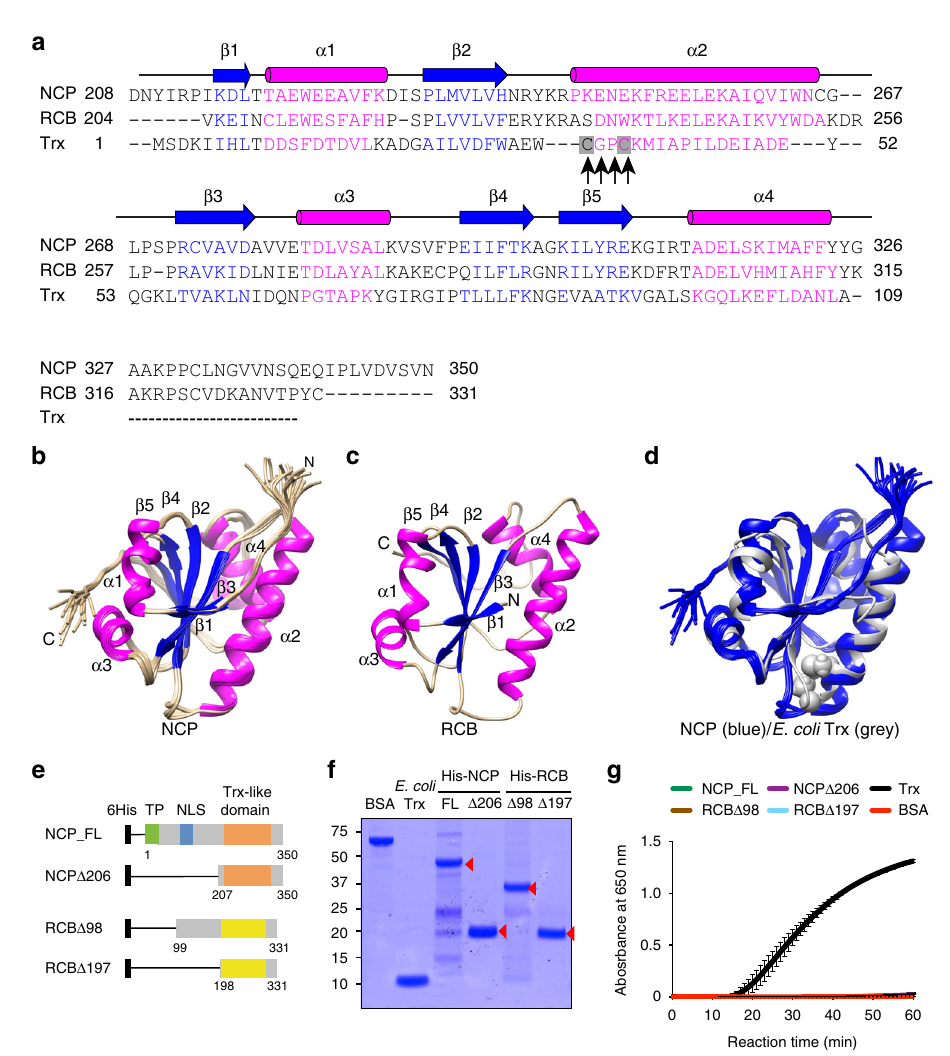
Fig. 6 NCP and RCB structurally resemble E. coli Trx but lack reductase activity. a Sequence alignment of the Trx-like domains of NCP and RCB with that of E. coli Trx. Magenta characters represent alpha helices and blue characters represent beta sheets. The black arrows indicate the conserved catalytic -Cys- X-X-Cys- motif in E. coli Trx. b NMR structures of NCP ’ s Trx-like domain (PDB ID: 6NE8). c Simulated structure of RCB ’ s Trx-like domain based on the NMR structure of NCP. d Overlay of the structure of NCP ’ s Trx-like domain with the crystal structure of E. coli Trx (PDB ID: 1XOB). The two cysteines in E. coli Trx are shown. e Schematic illustration of NCP and RCB fragments used for the in vitro Trx reductase assays. f SDS-PAGE gels showing BSA (negative control), E. coli Trx (positive control), and puri fi ed His-tagged recombinant NCP and RCB fragments. g Trx activity assays showing that recombinant NCP and RCB proteins lack Trx activity. Trx activity was determined based on the increase in turbidity after the reduction of insulin, as measured by the absorbance at 650 nm 53 . E. coli Trx and BSA proteins were used as a positive control and a negative control, respectively. The source data of the Trx activity assay in g are provided in the Source Data fi